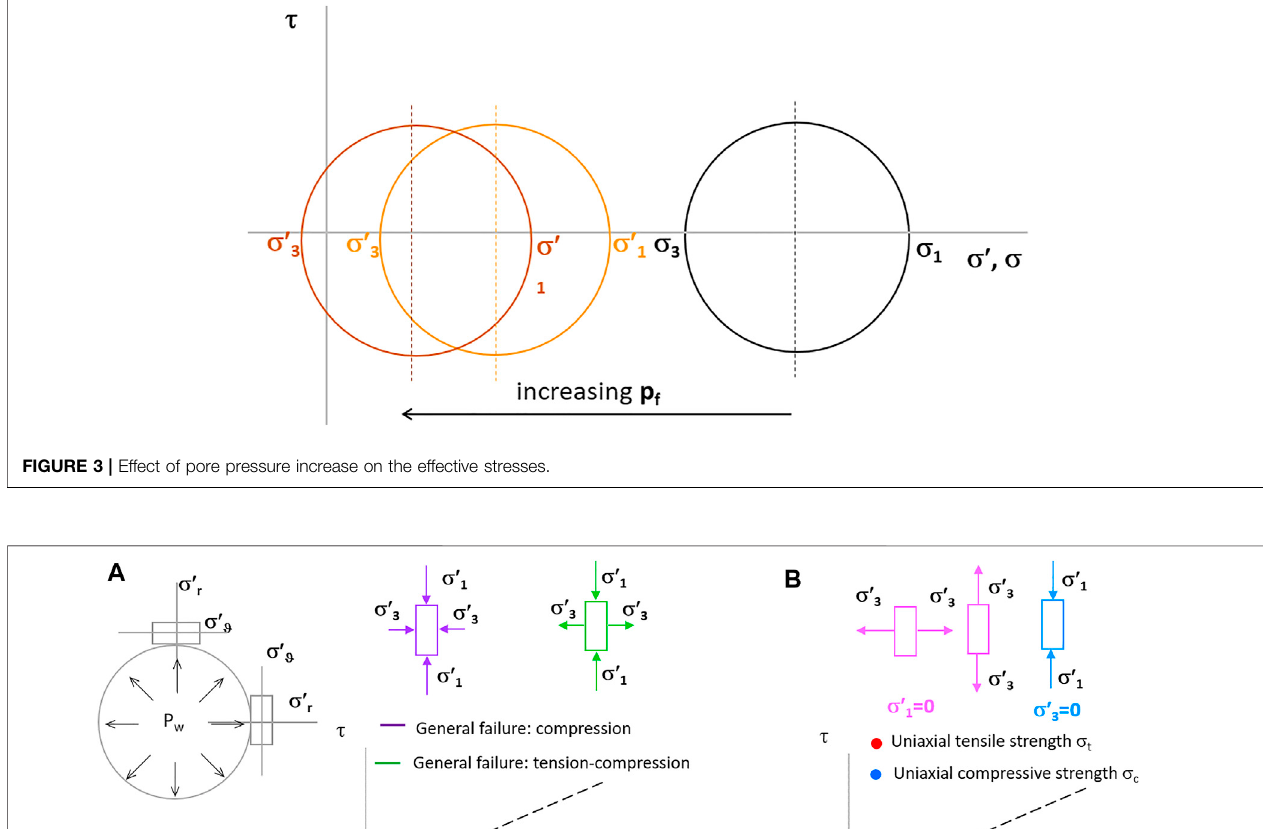
Frontiers in Earth Science |